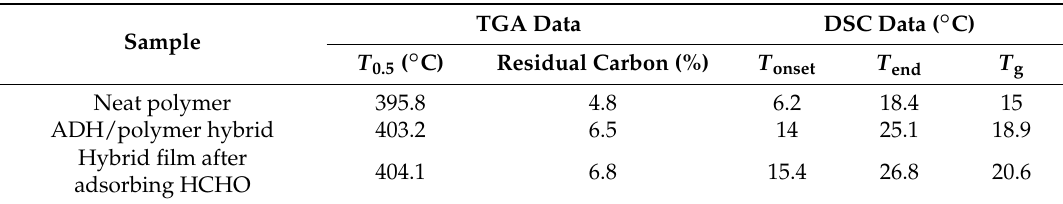
Table 3. Thermal properties of poly (methyl methacrylate-butyl acrylate-methacrylic acid) (P(MMA-BA-MAA)), P(MMA-BA-MAA)/ADH, and P(MMA-BA-MAA)/ADH-HCHO TGA-thermo gravimetric analysis.